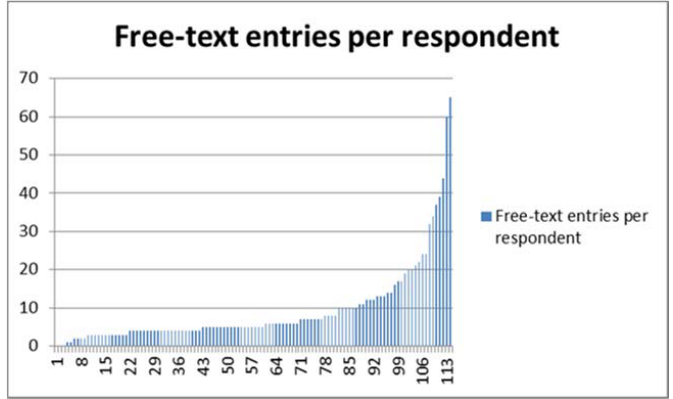
Figure 5. Free ‐ text entries across all parts of the survey, shown in ascending order by respondent. Figure 5. Free-text entries across all parts of the survey, shown in ascending order by